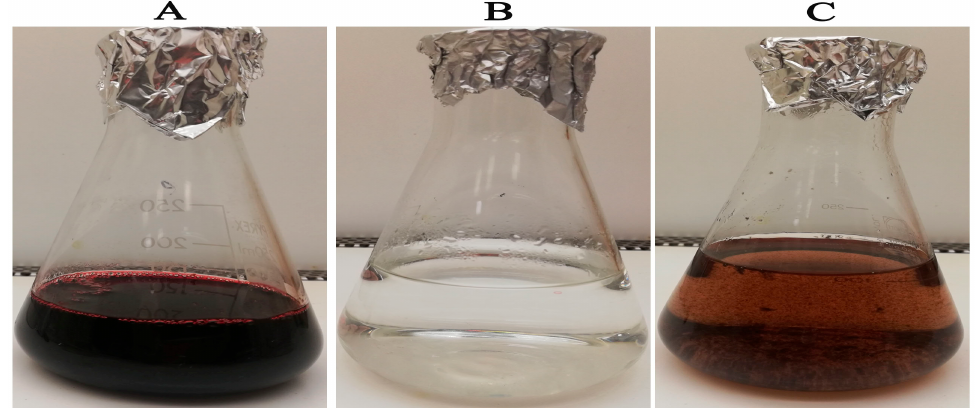
Figure 1. Reduction of Zn (NO 3 ) 2 .6H 2 O solution using the flower extract into biogenic ZnO-NPs ( A ) H. sabdariffa extract, ( B ) colorless zinc nitrate solution, and ( C ) the reduced solution.